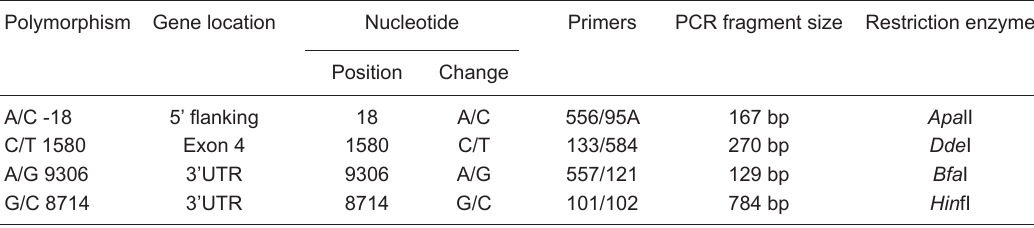
Table 3. Location of polymorphism sites of the SP-B